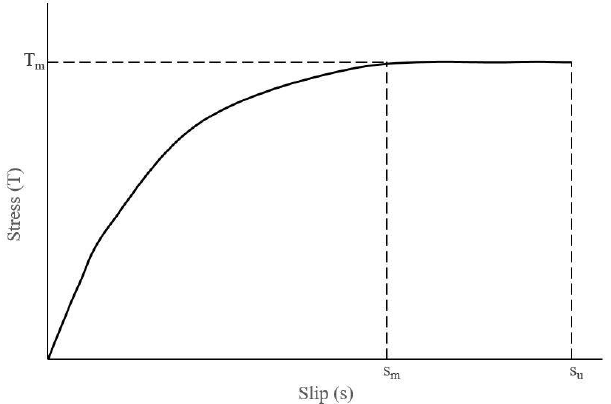
Figure 4. Schematic representation of bond-slip model.